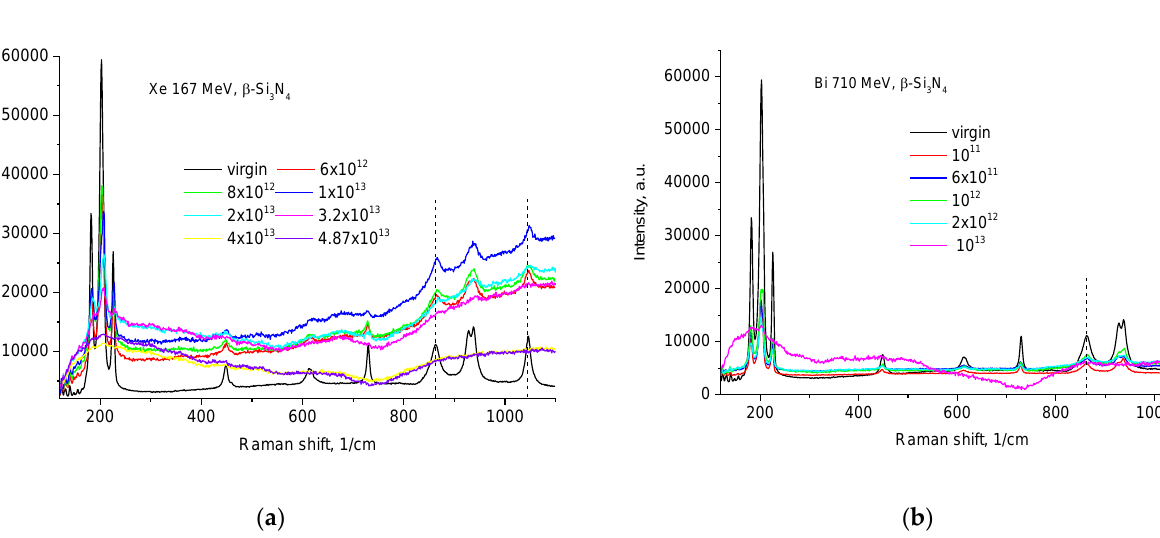
Figure 1. The dose dependence of Raman spectra of Si 3 N 4 irradiated with ( a ) Xe (167 MeV) and ( b ) Bi (710 MeV) ions. The dashed lines indicate positions of 862 cm −1 and 1045 cm −1 lines.